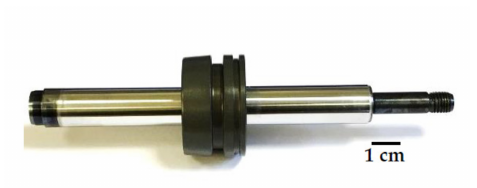
Figure 1. Anodized Al rod guide and hard Cr